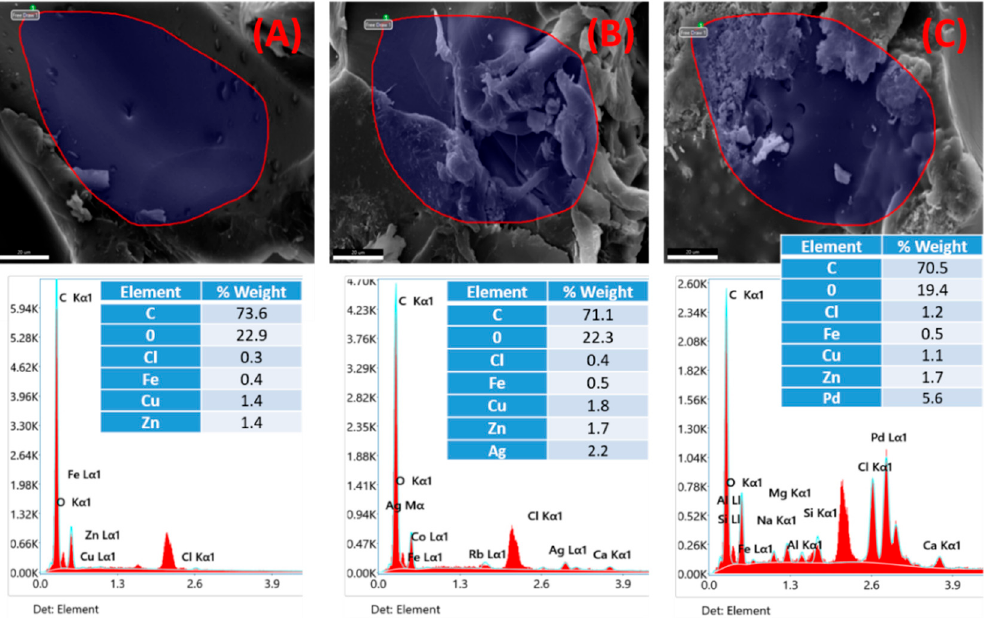
Figure 3. Elemental analysis of ( A ) pure NIPAM-based cryogel ( B ) silver nanoparticles embedded hybrid cryogel and ( C ) palladium nanoparticles embedded hybrid cryogel.